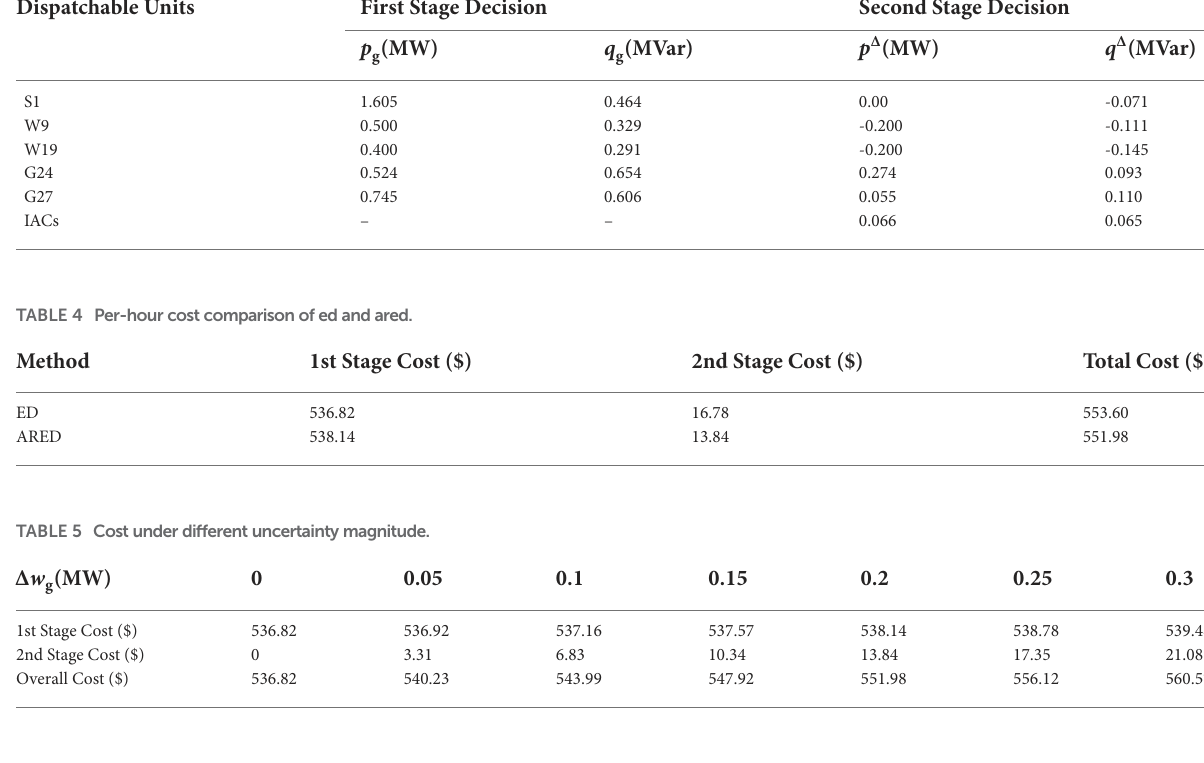
TABLE 3 Resultsofared’sfirstandsecondstagedecision.